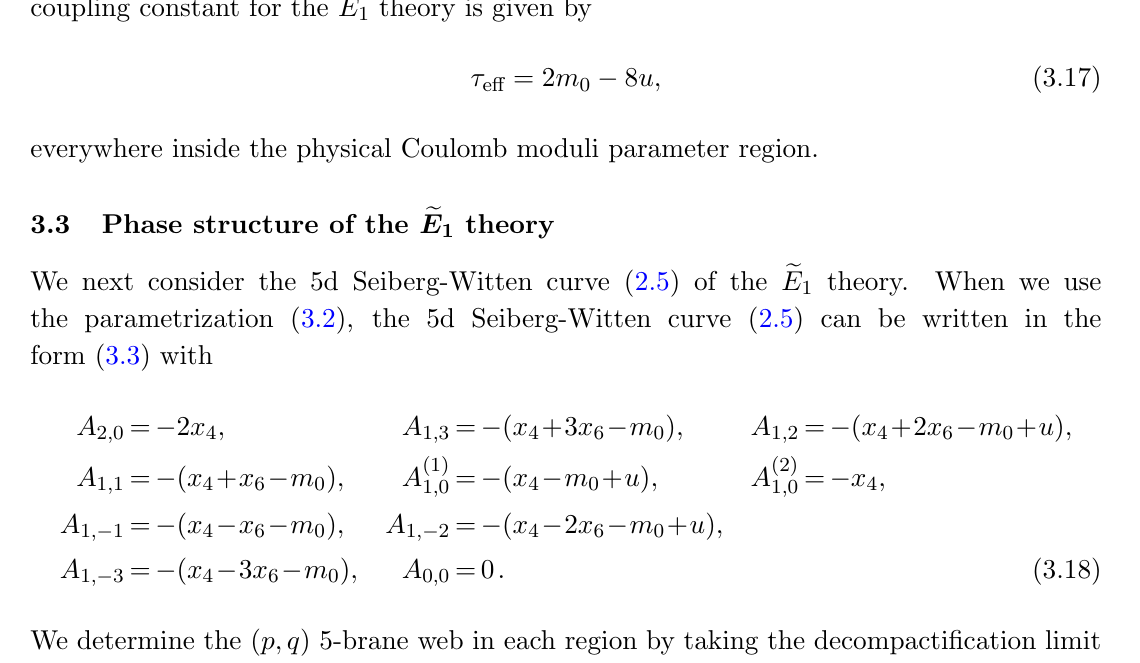
Figure 8. The phase diagram of the u = m 0 . The boundary of the physical parameter region is given by u = 1 for m 0 (cid:21)